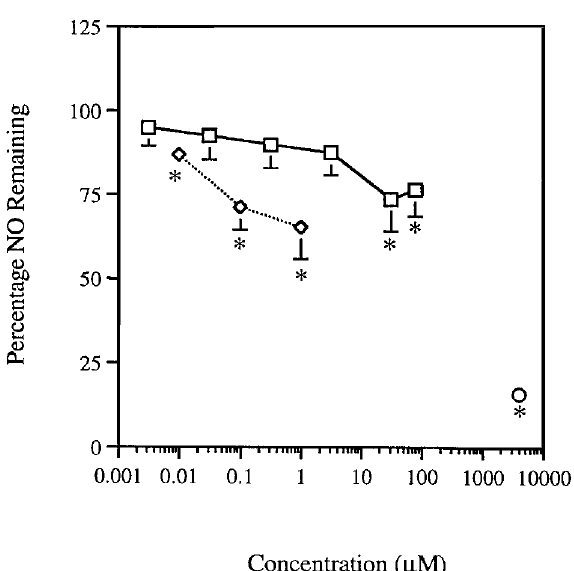
FIG. 3. Effect of Ac2–26 and dexamethasone on NO release by LPS-stimulated rat AM in vitro (10 m g/ml LPS). Percentage NO remaining following L-NMMA, peptide or dexametha- sone treatment was calculated using the following